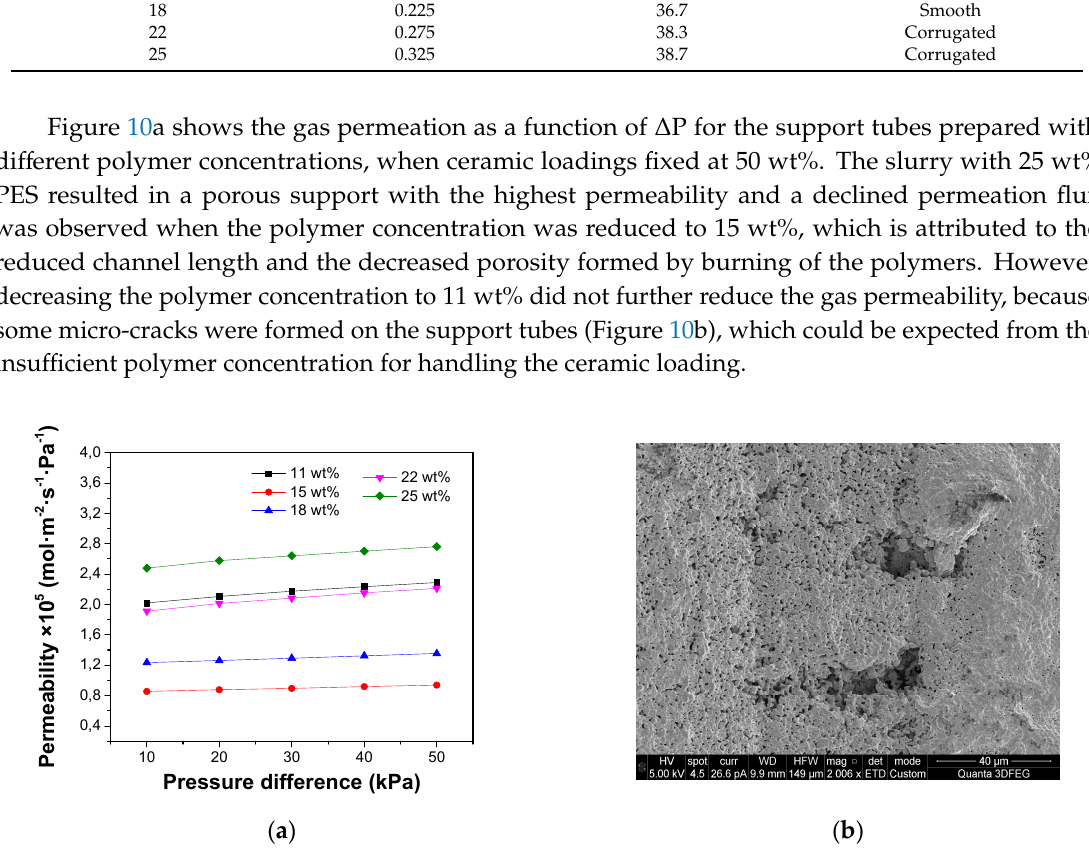
Figure 10. ( a ) Nitrogen permeability through MgO-CGO supports fabricated from slurries with different polymer concentrations; ( b ) SEM image of cracks on the support tube made from a slurry with 11 wt% polymer concentration.